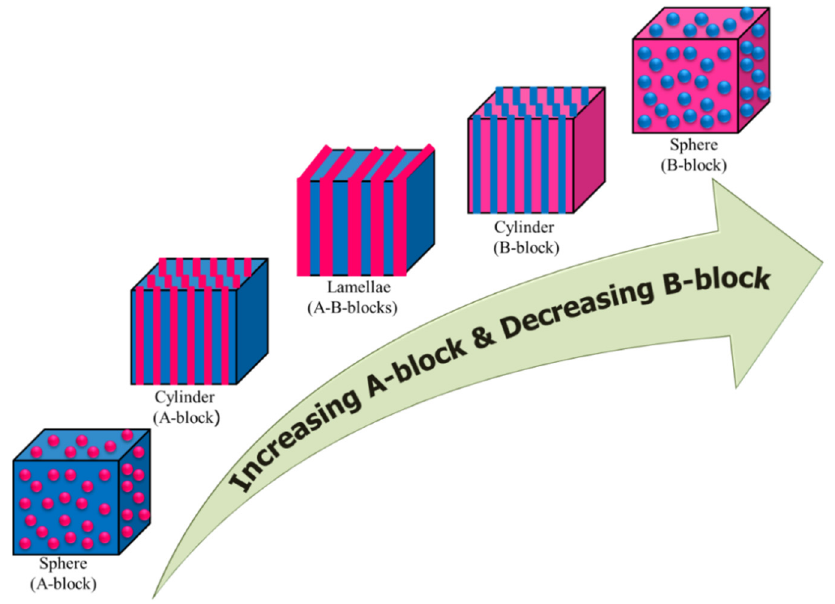
Figure 4. Schematic illustration of diblock copolymer showing various microdomains depending on the relative composition of the blocks.